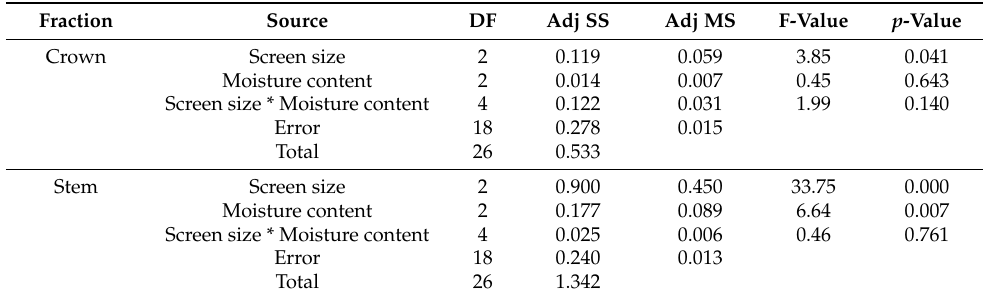
Table 3. ANOVA effects of screen size and moisture content on the relaxed density of crown and stem fractions of the briquette ( p < 0.05).